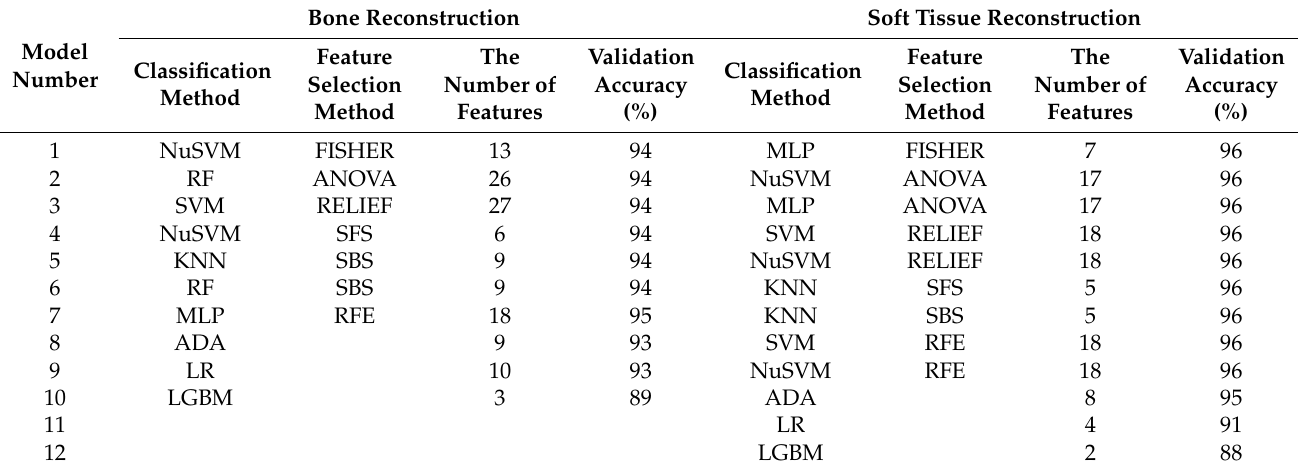
Table 2. Basic information about optimal models for particular feature selection methods.